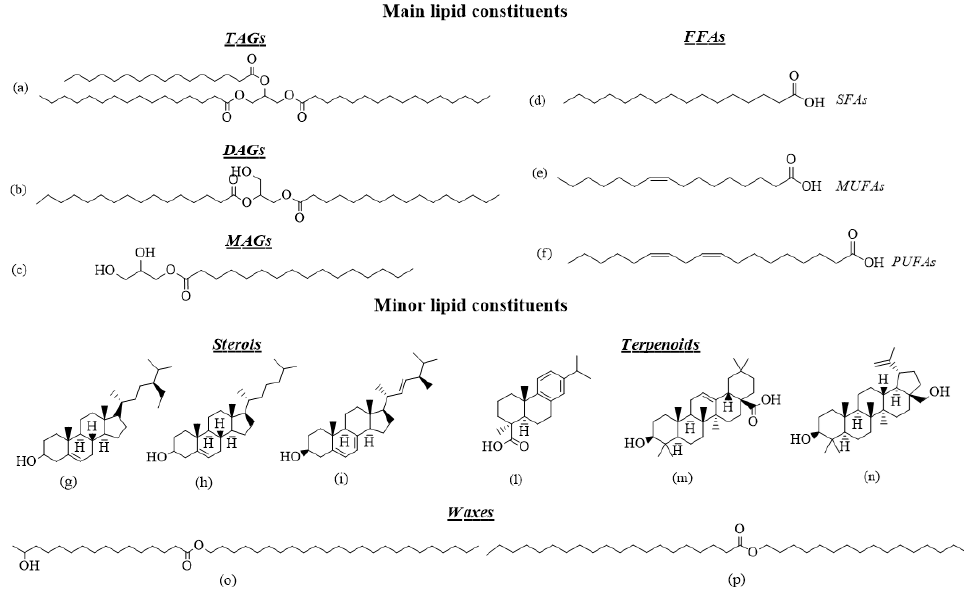
Figure 1. Examples of lipids detected in archaeological pottery samples: ( a ) tripalmitoylglycerol, ( b ) 1,3-dipalmitoyl-glycerol, ( c ) 1-palmitoyl-glycerol, ( d ) palmitic acid, ( e ) palmitoleic acid, ( f ) linoleic acid, ( g ) sitosterol, ( h ) cholesterol, ( i ) ergosterol, ( l ) dehydroabietic acid, ( m ) oleanolic acid, ( n ) betulin, ( o ) tetracosanyl 15-hydroxypalmitate, ( p ) hexadecyl eicosanoate.